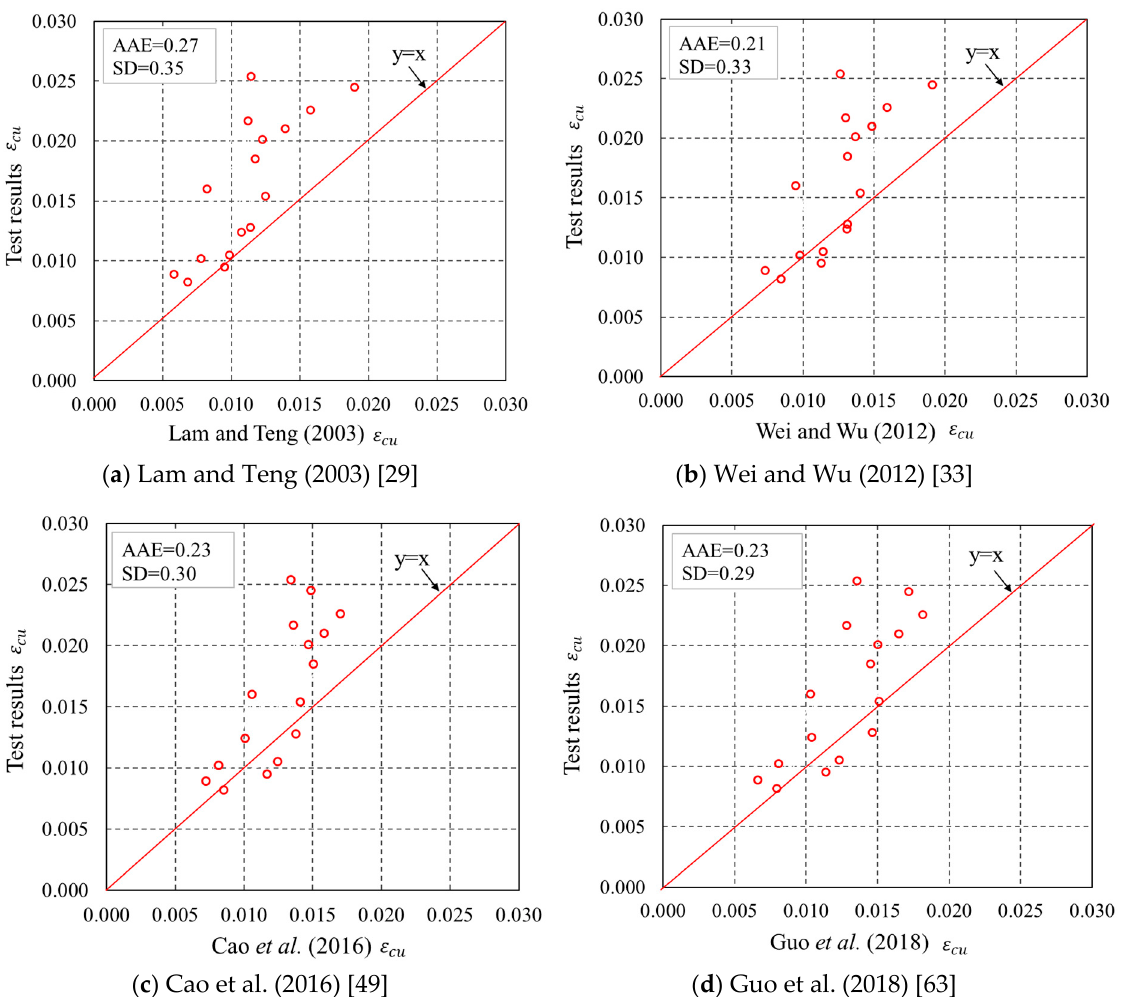
Figure 17. Performance of the existing models in predicting the ultimate axial strains.